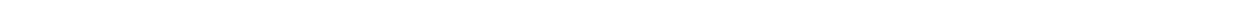
Fig. 2 Effect of nuclear lamin A/C on nuclear morphology. a – f Lamin A/C-dependent difference of nuclear morphology in MEFs placed in a glass bottom dish. Representative cell and nuclear morphology in lamin A/C-present control wild-type (WT) and lamin A/C-de fi cient Lmna knockout ( Lmna − / − ) MEFs were captured by 3D reconstruction of immuno fl uorescence confocal images along the z -axis ( a , b ). Note that apical, basal, and side views of pseudo- colored 3D z -depth rendered nuclei display the differences in the nuclear surface textures. Lmna − / − cells displayed more spread ( c ), rounder ( d ), larger ( e ), and thicker ( f ) nuclei than the WT control cells. g – j Comparison of lamin A/C-dependent lateral deformation of the nucleus. Tracking surface contours in three different altitudes in a nucleus displays signi fi cantly more peak positions (gray dots) in Lmna − / − cells than WT cells ( g – i ), representing more protrusions on the nuclear surface of the Lmna − / − MEFs. Relative radius is the ratio between the nuclear center-to-edge distance and the equivalent circular radius, where top (blue), middle (green), and bottom (red) parts correspond to the top 25%, top 50%, and top 75% positions along the z -axis of the nucleus, respectively. Average number of peaks in relative radii of three different altitudes was termed by the nuclear lateral bumpiness ( j ). In c – j , > 30 cells were analyzed per condition. Error bars represent S.E.M. of averaged values and statistical differences were calculated using the unpaired t -test; *** p < 0.0001, ** p <